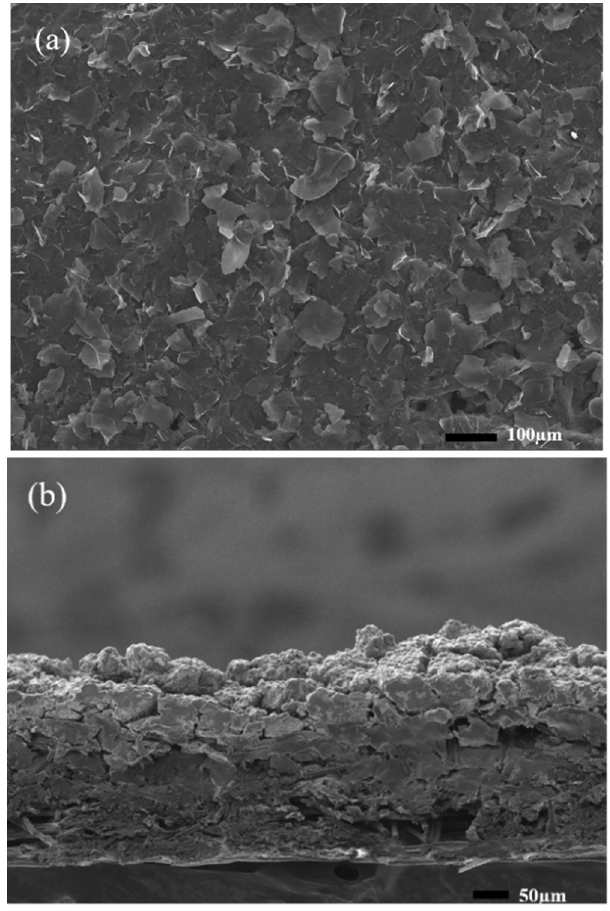
Figure 6. SEM images of the ( a ) top surface and ( b ) cross section of the double microporous layer electrode.